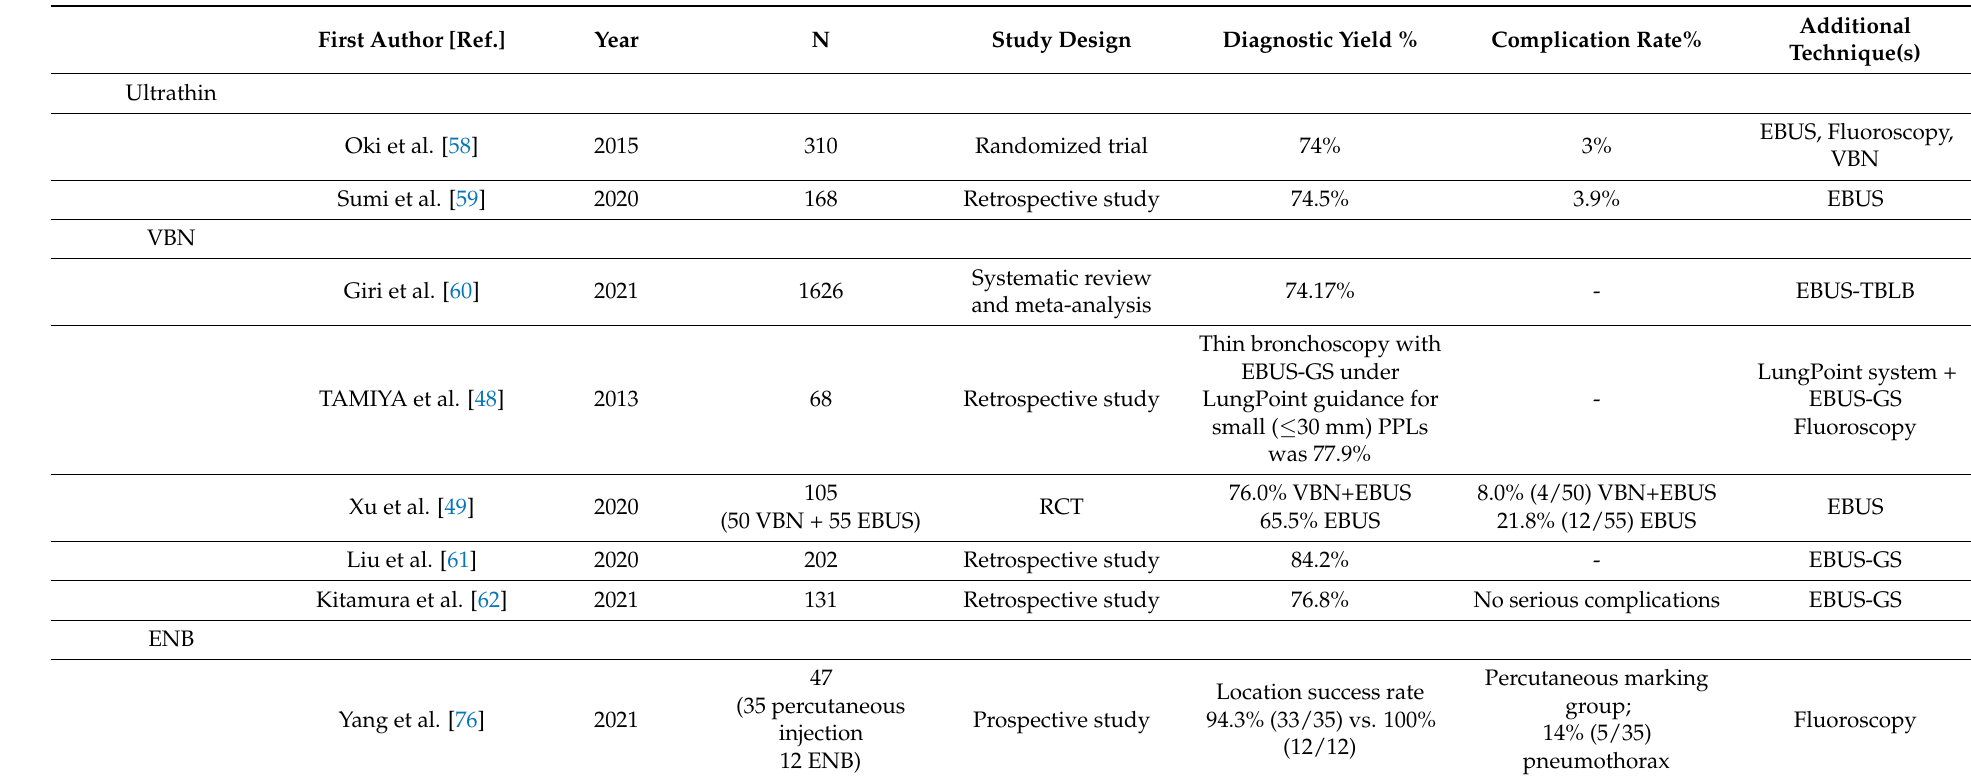
Table 1. Clinical trial